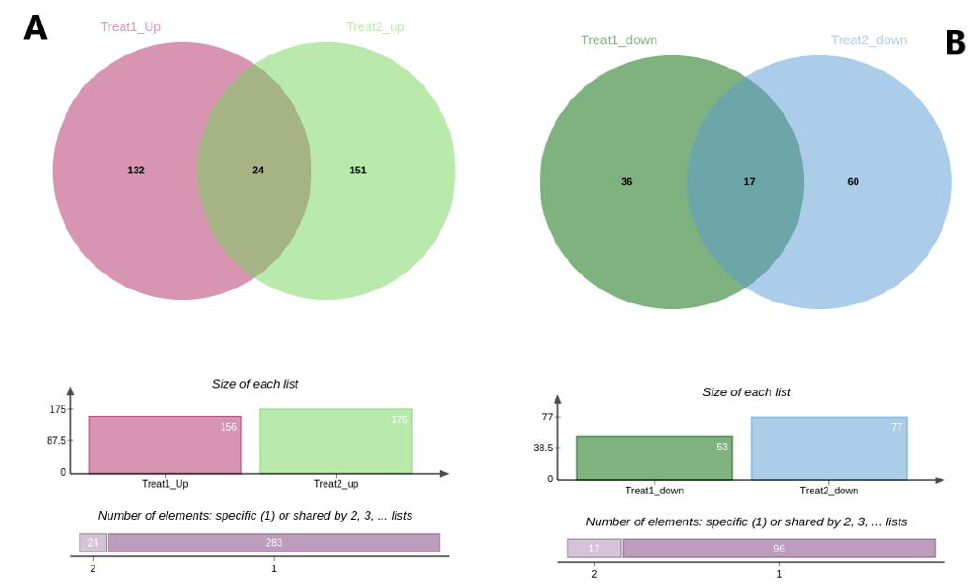
Figure 4. Venn diagram displaying the number of genes that were up- and down-regulated in the ammonia and stocking density treatments. ( A ) Up-regulated genes in ammonia and stocking density treatment. Pink color represents ammonia treatment, green represents stocking density while the intersection represents the common elements. ( B ) Down-regulated genes in ammonia and stocking density treatment. Green color represents ammonia treatment, blue color represents stocking density treatment and the intersection represents the common elements.